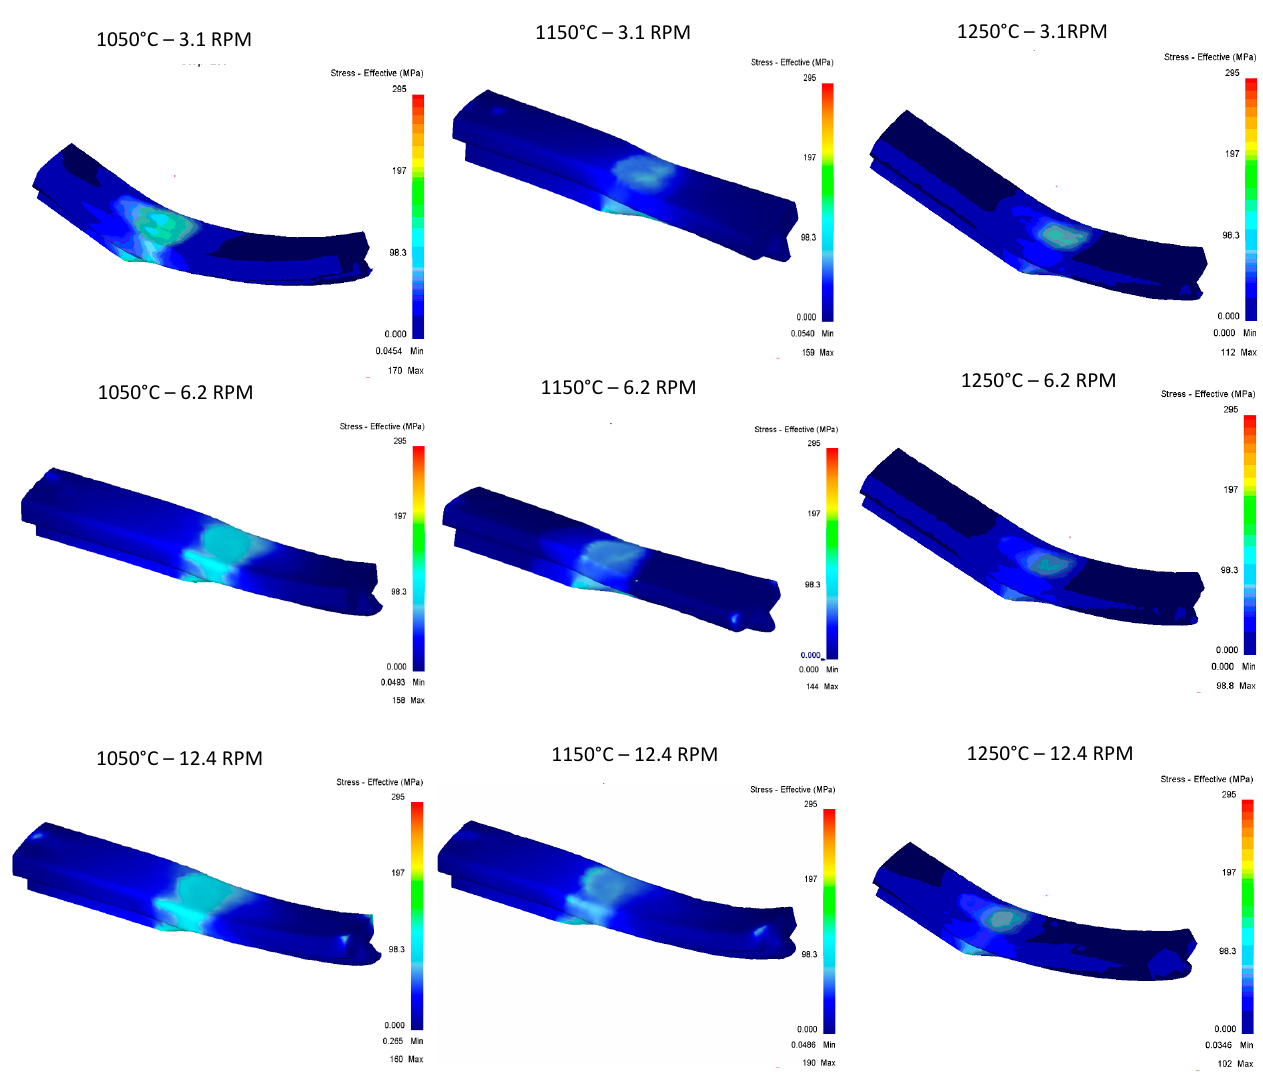
Figure 10. Effective stress in the top Rail after first pass. Figure 11 shows the effective strain comparison between results from the first rolling pass. As roll speed increases, more highly concentrated strain regions are detected in the thinner region of the geometry.